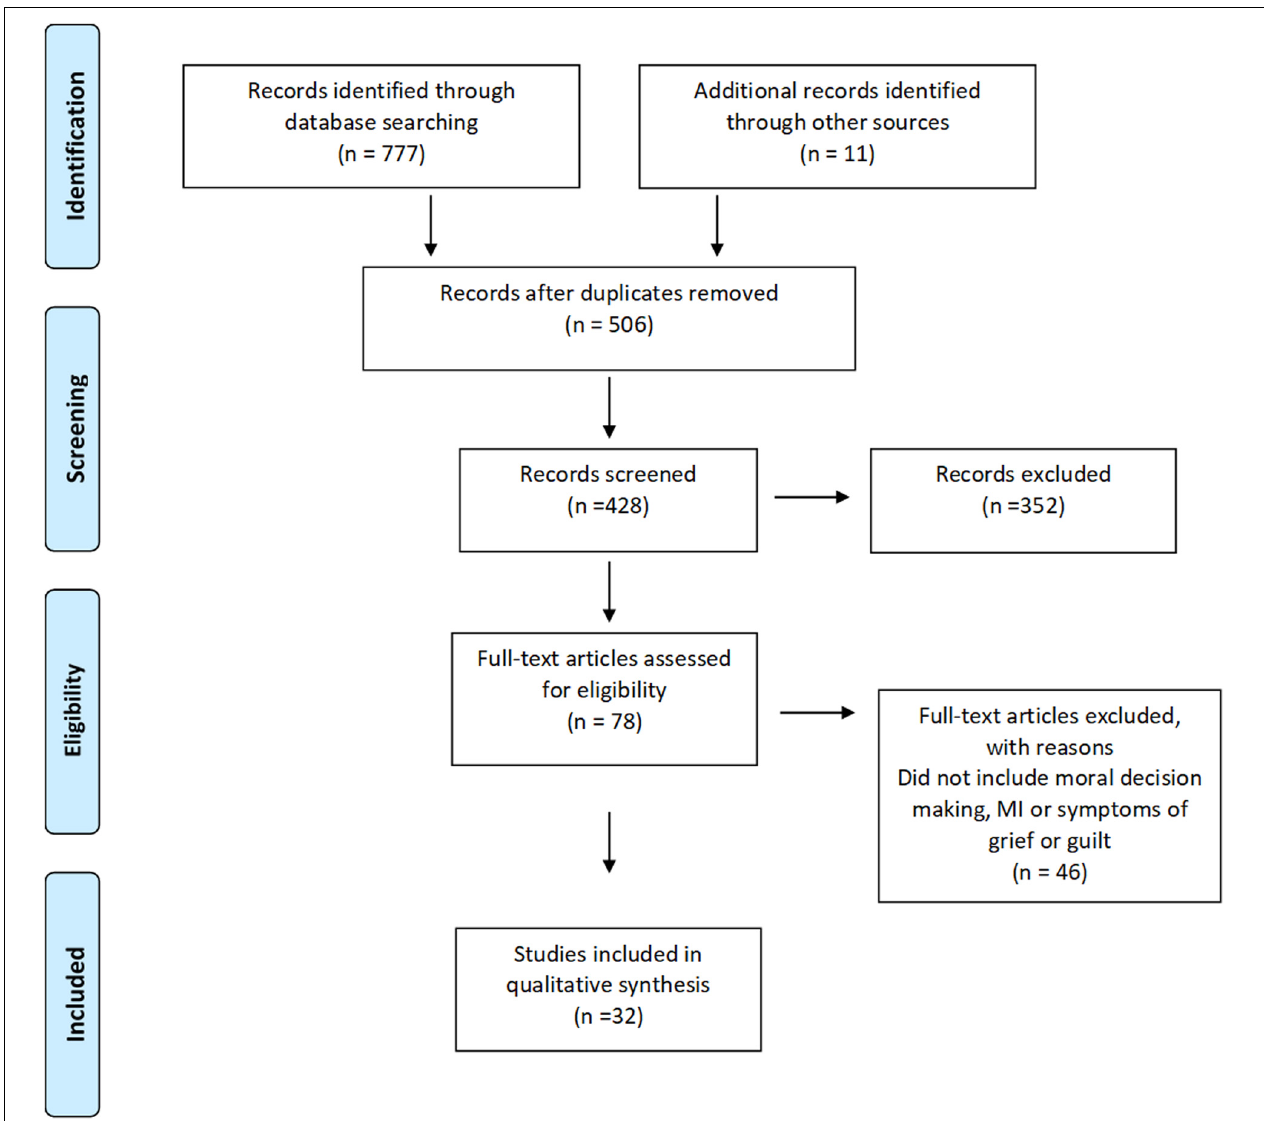
FIGURE 1 | Prisma flow